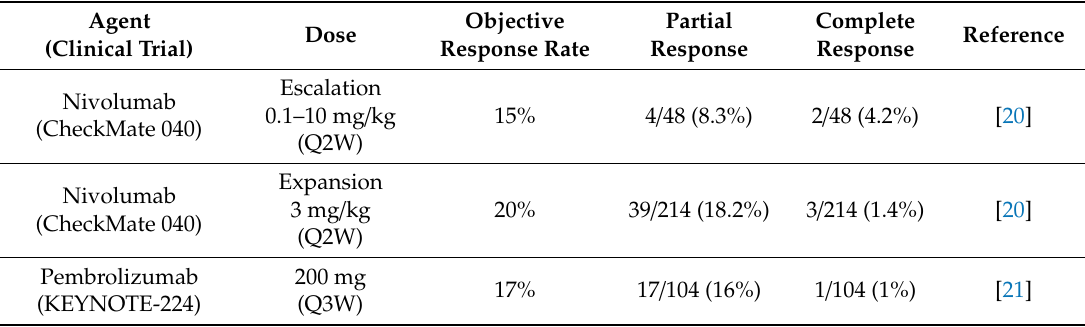
Table 1. Results obtained from clinical trials of programmed cell death protein 1 (PD-1) inhibitors in hepatocellular carcinoma (HCC). Administration every two weeks (Q2W) and every three weeks (Q3W).